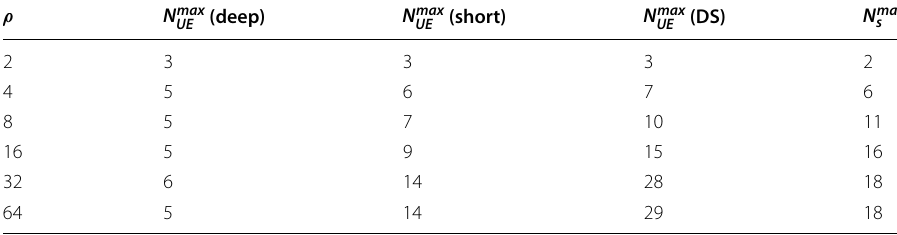
Table 6 Maximum number for N UE in channel scenario A